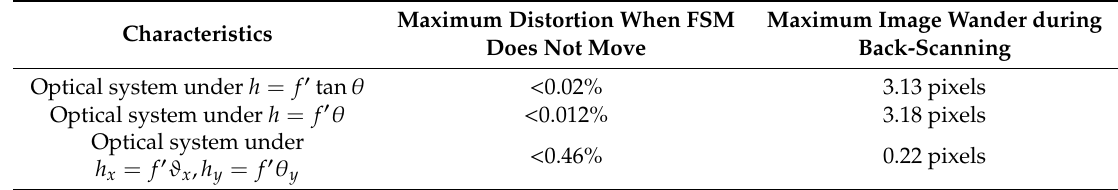
Table 2. Distortion characteristics and image wander